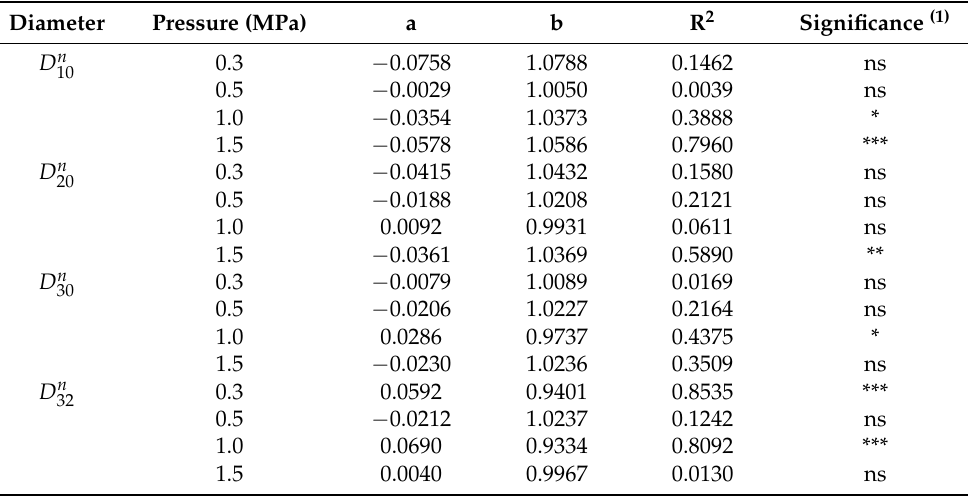
Table 4. Regression equations between normalized mean diameters and normalized threshold values (y = ax +